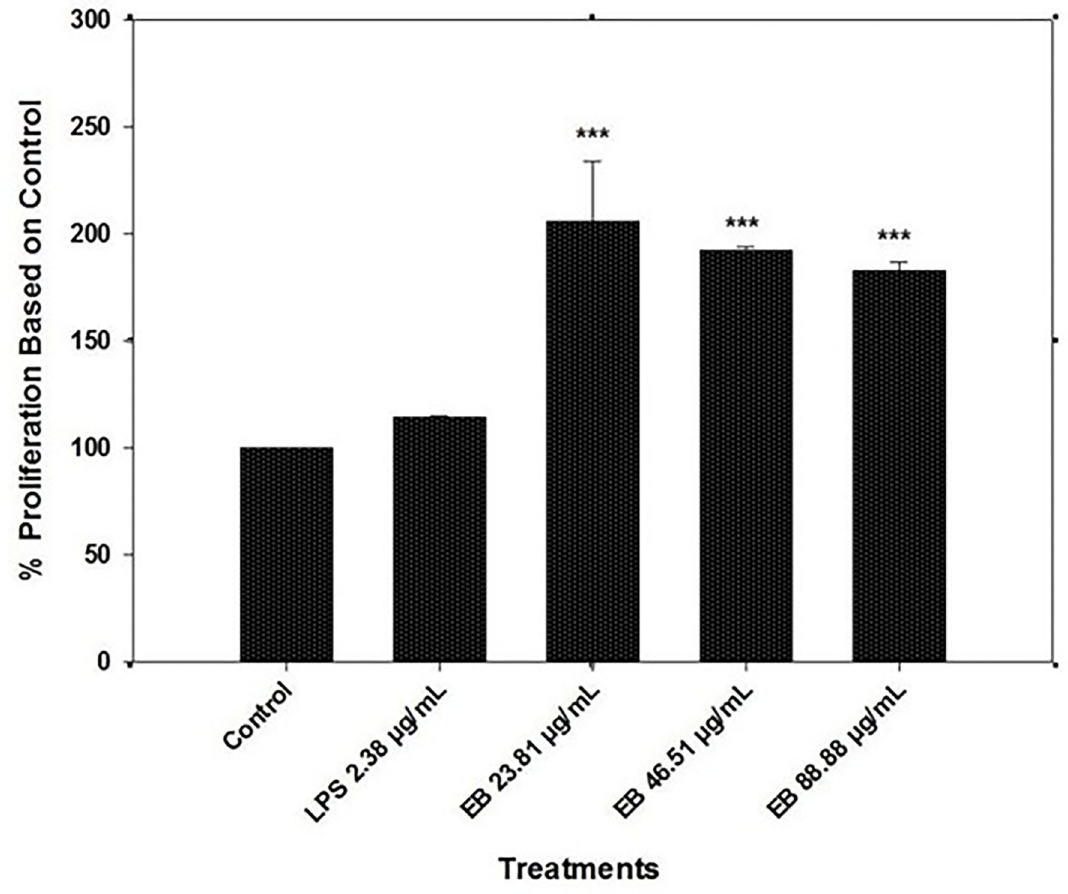
Fig 3. Proliferation of fish spleen B-cells in the prescence of LPS and various concentrations of elderberry extracts (23.81 μ g/mL, 46.51 μ g/mL, and 88.88 μ g/mL). All the elderberry extract concentrations were tested in the presence of LPS. Results are represented in means ± SEM. Asterisks represent a significant proliferation difference between treatment and control cell growth ( ��� = P < 0.001).